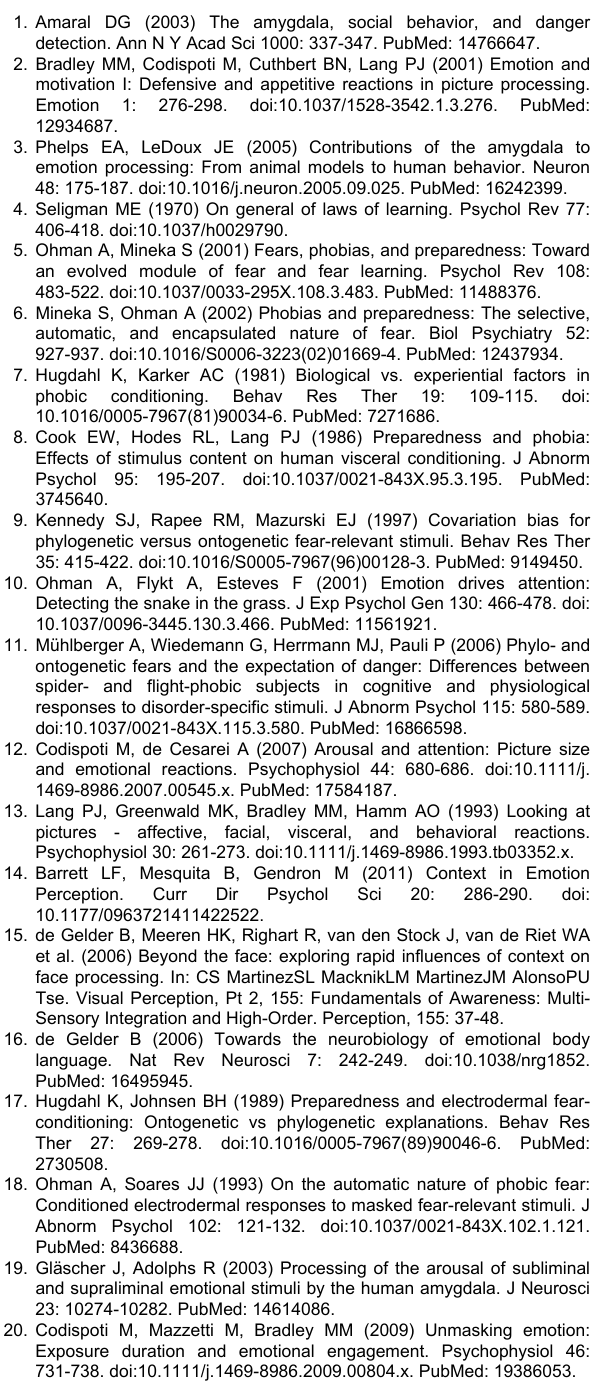
Table S1. Familiarity and complexity scores in Experiment 1.